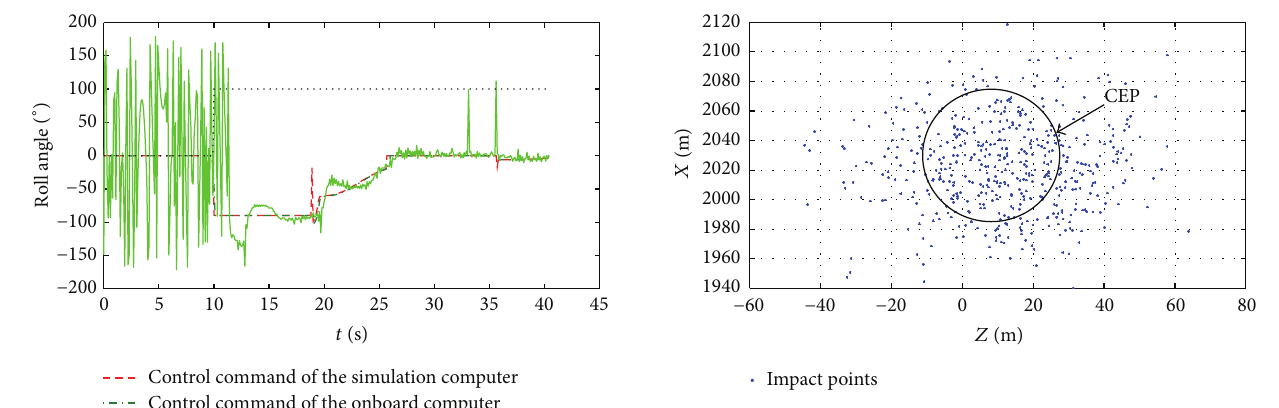
Figure28:MonteCarlodispersionspreadandCEPforuncontrolled condition.